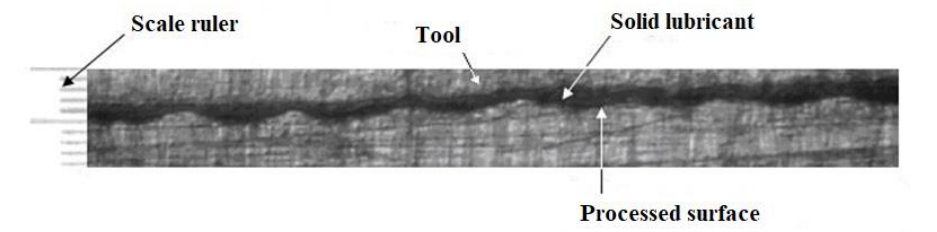
Fig. 4. Contact of the tool with the processed surface when using solid